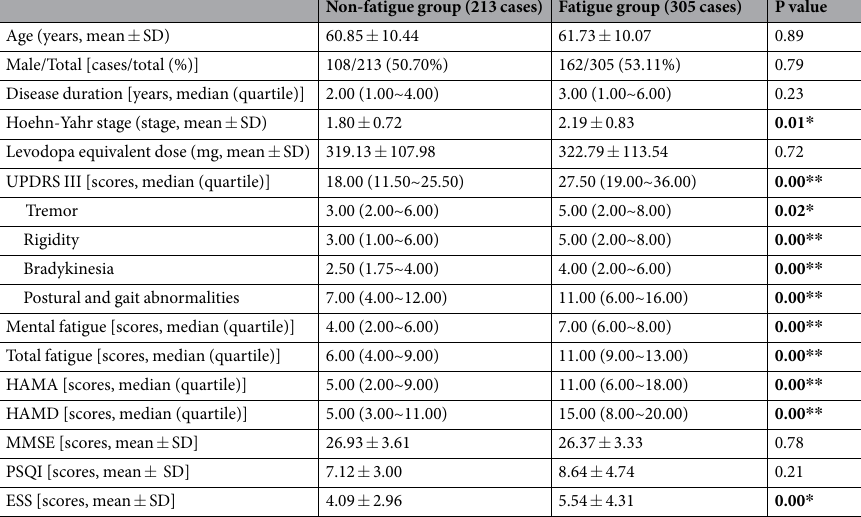
Table 1. Demographics information, motor and non-motor symptoms in non-fatigue and fatigue groups. HAMD = Hamilton Depression Scale (24 items); HAMA = Hamilton Anxiety Scale (14 items); UPDRS = Unified Parkinson’s Disease Rating Scale; MMSE = mini-mental state examination; PSQI = Pittsburgh Sleep Quality Index. * P < 0.05, ** P < 0.01.